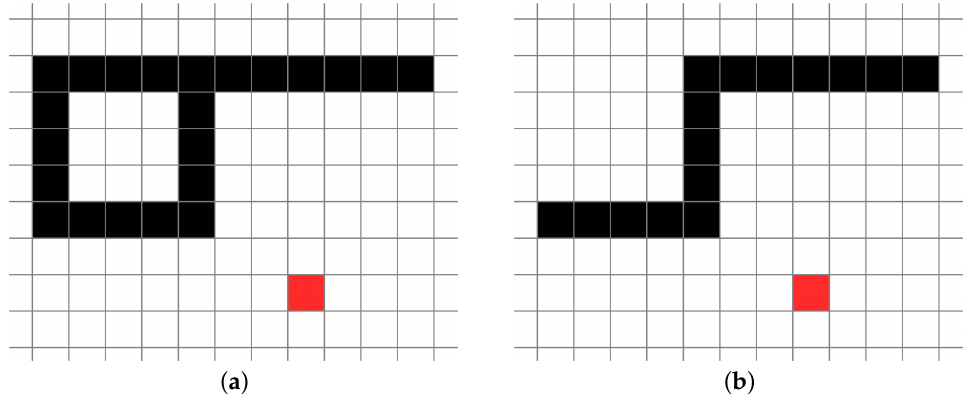
Figure 4. Example of the non-occluded pixels: ( a ) the black pixels are contour pixels in foreground lines, the white pixels are background pixels, and the red pixel denotes pixel i in the background pixels; ( b ) the non-occluded pixels in the contour pixels are exposed to the light from i , assuming that there is a light source at i